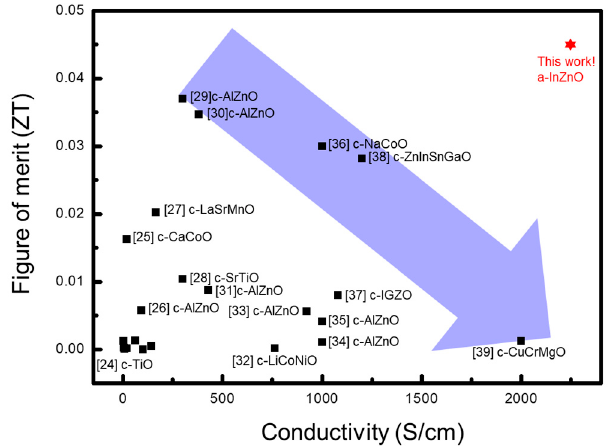
Figure 1. Thermoelectric figure of merit of oxide thin films as a function of conductivity. The ZT measured at other temperature is calculated to 300 K.